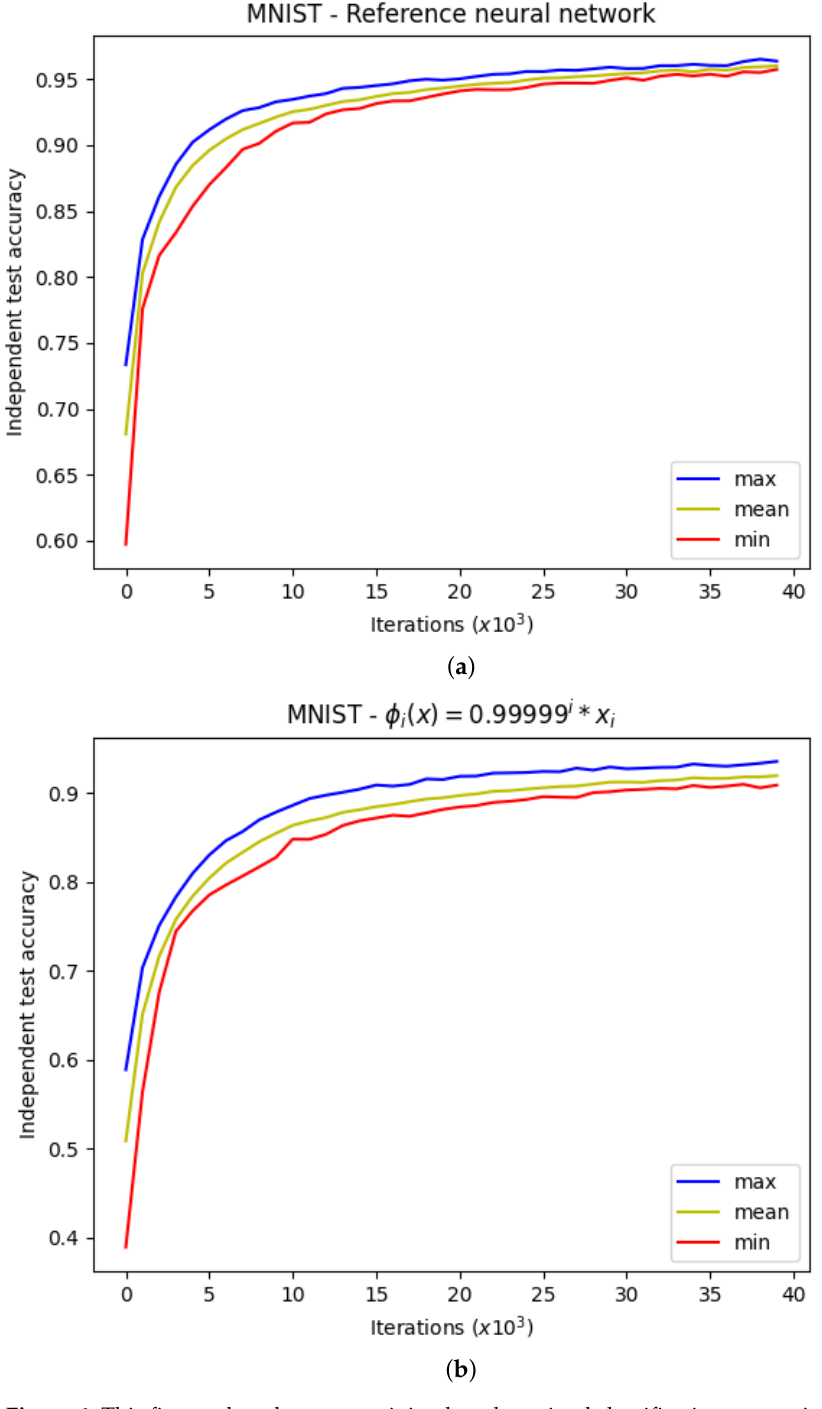
Figure 6. This figure plots the mean, minimal, and maximal classification accuracies during training, averaged from five independent training sessions on the MNIST dataset. The top image ( a ) depicts the classification accuracies with the reference convolutional neural network (baseline), while the lower image ( b ) plots the same results using an SAW convolution-based kervolutional neural network with an attenuation parameter of 99,999. The blue color is the maximum accuracy, the yellow color is the mean accuracy, and the red line shows the minimum accuracy. As can be seen, there were no significant differences between the two